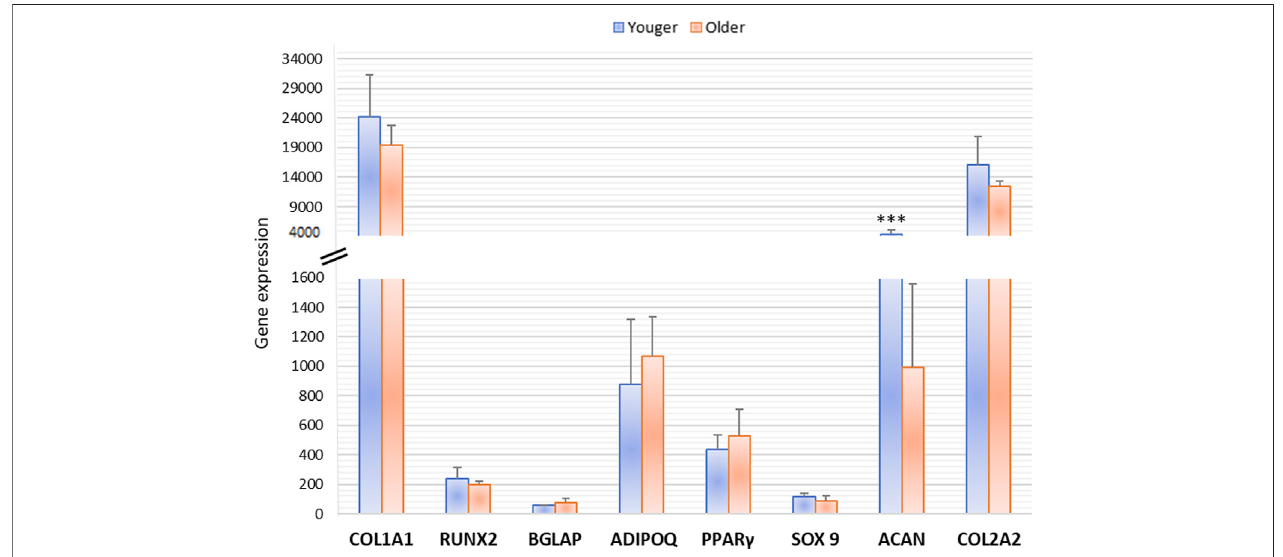
FIGURE 9 | Gene expression measured by semiquantitative PCR of osteogenic (COL1A1, RUNX2, BGLAP), adipogenic (ADIPO Q, PPAR γ ), and chondrogenic (SOX9,ACAN, COL2A1)markerscomparing the differentiation potential ofMSCsderived from clotted BMAs from youngerand older donors. ACAN: *** younger versus older (*** p < 0.0005).